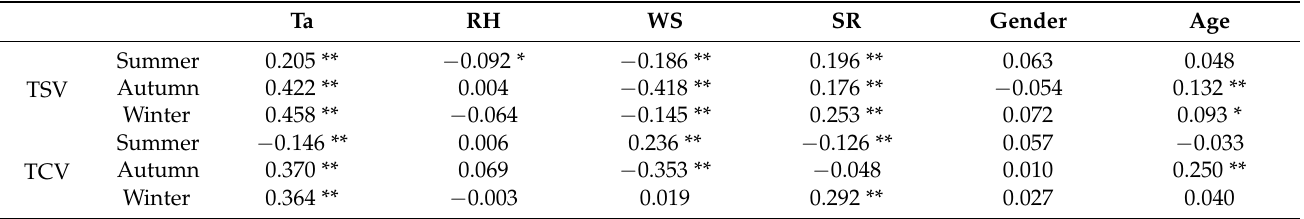
Table 4. The correlation analysis of TSV and TCV with six variables in summer, autumn, winter, and three seasons.